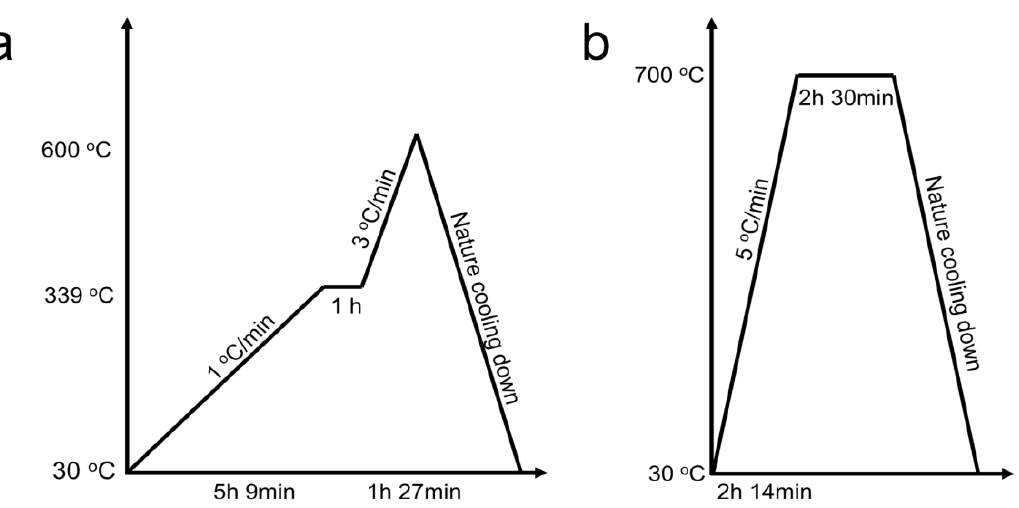
Fig. 1. Carbonization profile:; (a) first step carbonization; (b) second step